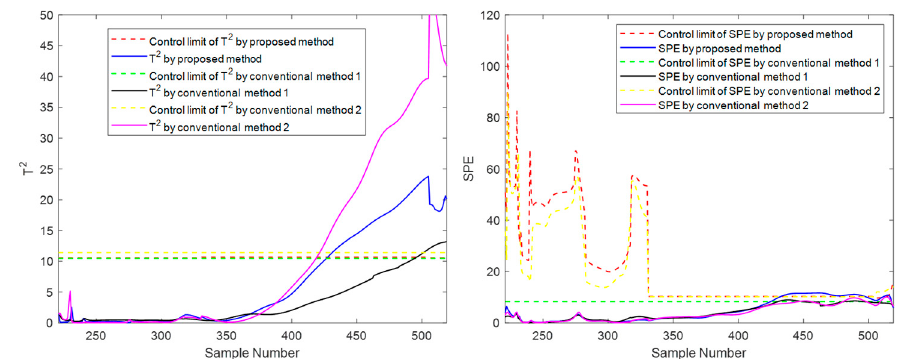
Figure 17. Online monitoring and fault diagnosis of batch 71 after introducing the fault.